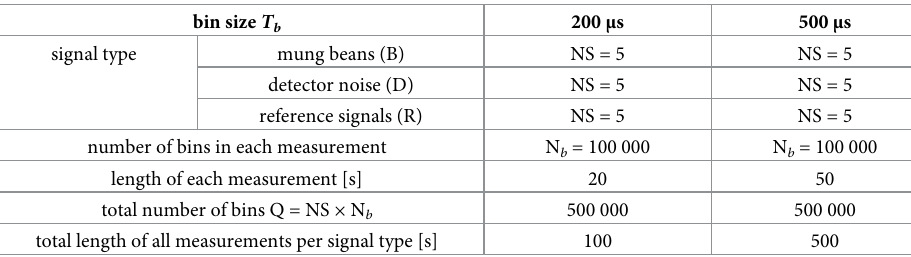
Table 2. Number and type of the signals